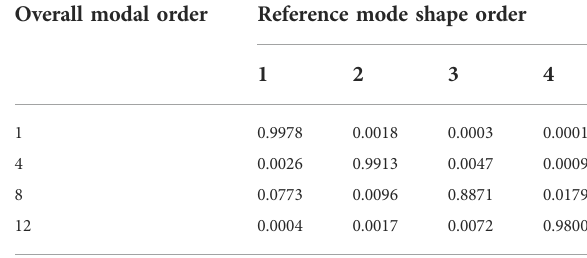
TABLE 2 Calculation results of the MAC value of the No. 3